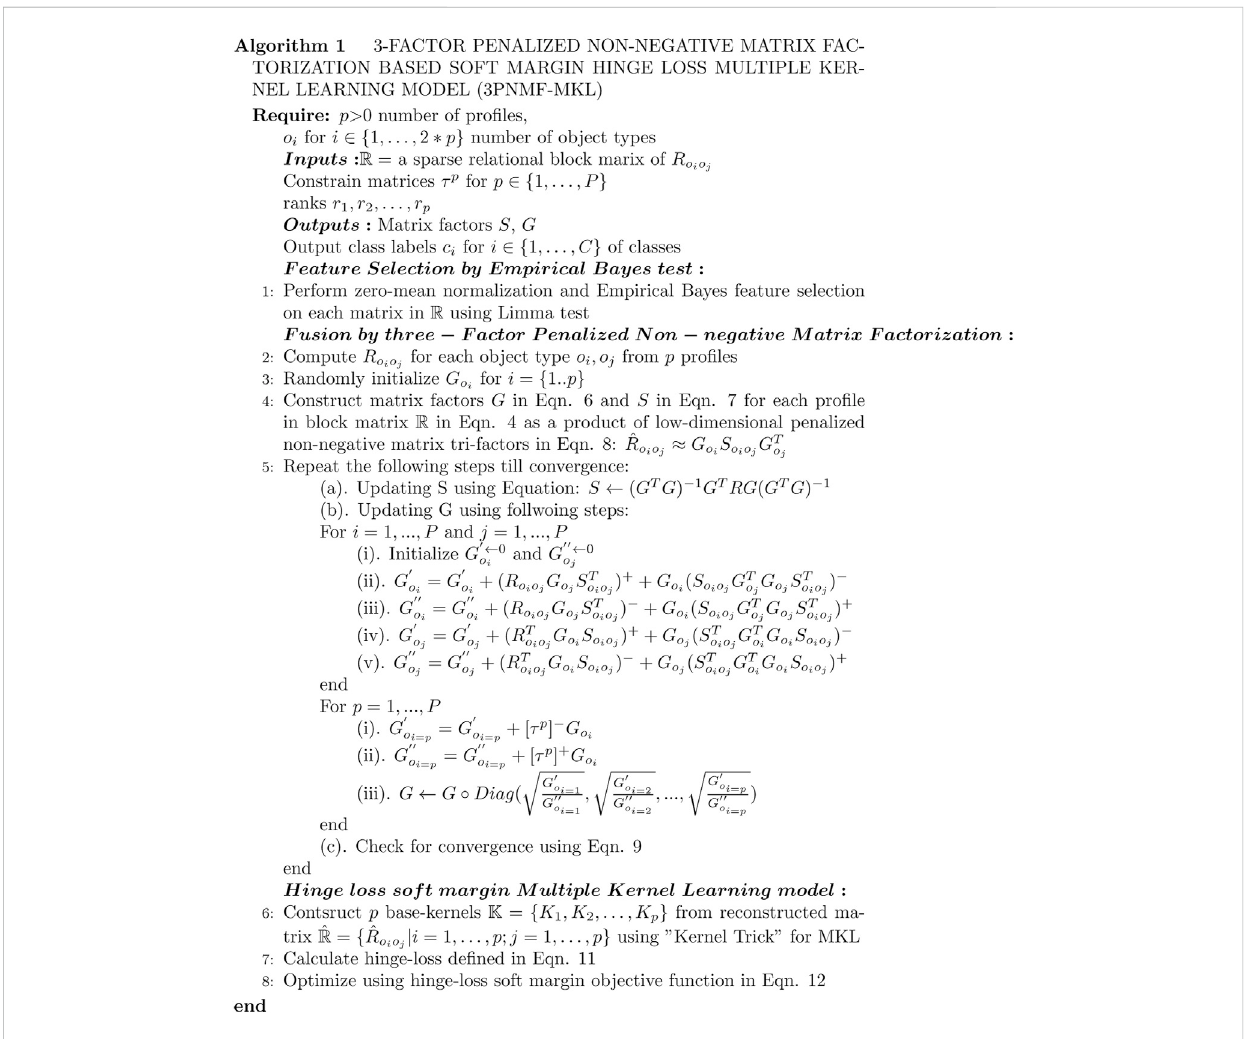
FIGURE 1 Algorithm of the proposed 3PNMF-MK